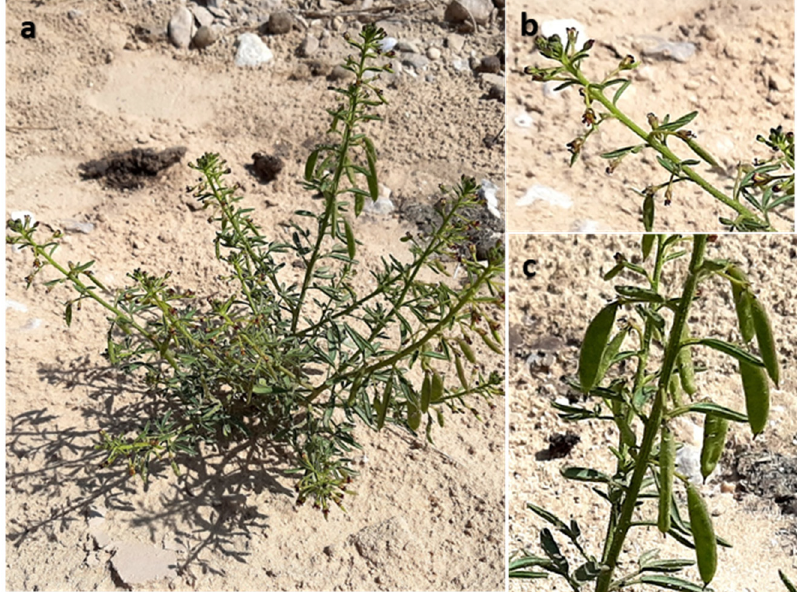
Figure 7. Cleome amblyocarpa Barratte & Murb. ( a ) Whole flowering plant, ( b ) enlarged flowering branch, and ( c ) enlarged fruiting branch. Photos were taken by Dr. Yasser El-Amier during spring of the year 2018 in Wadi Hajoul, eastern desert, Egypt.